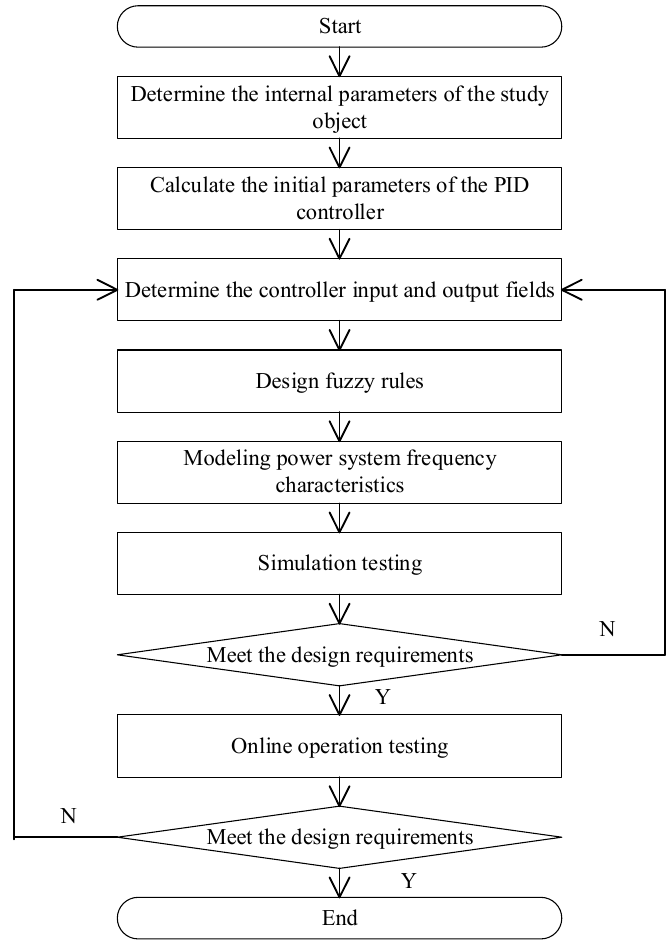
Figure 10. Design flow chart of fuzzy PID controller for frequency regulation.